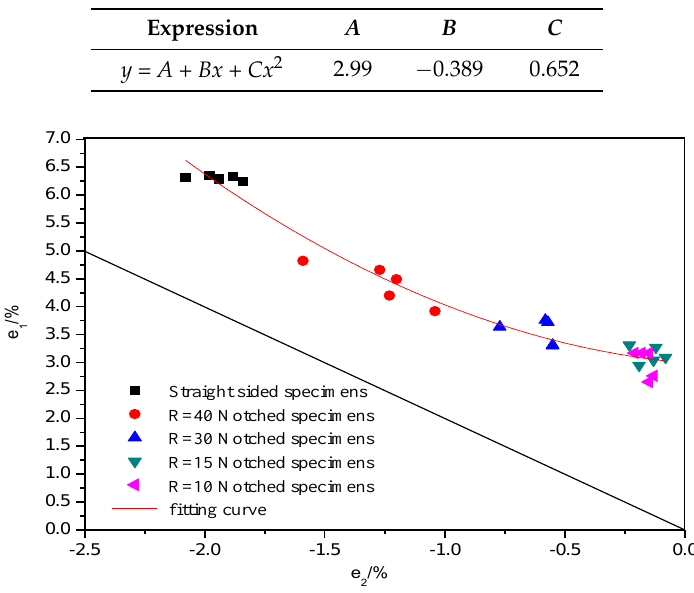
Table 5. Binomial fitting results.